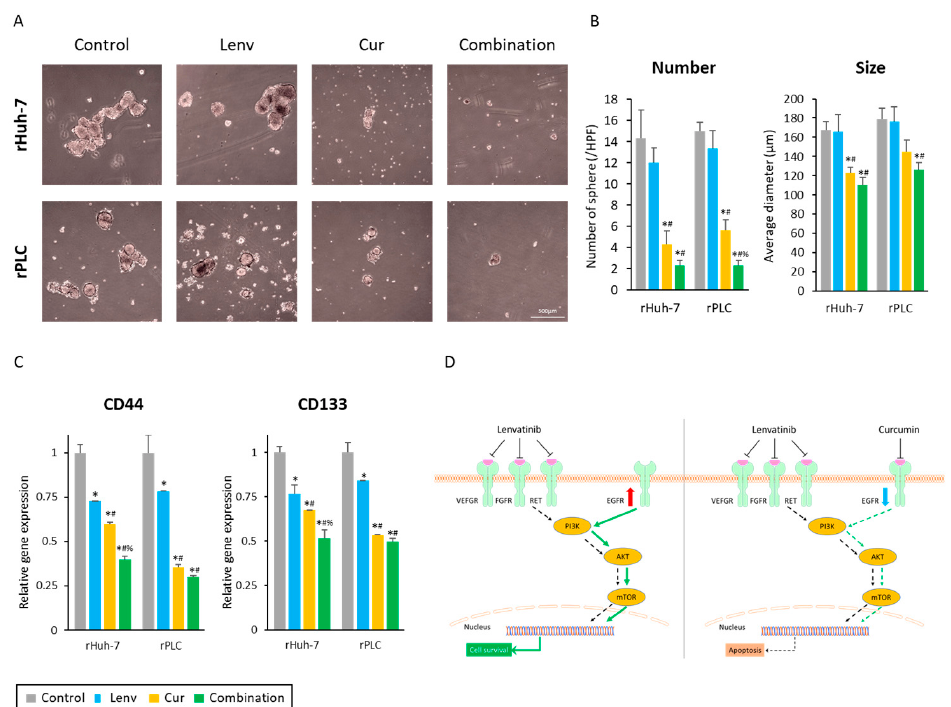
Figure 7. Co-administration of Lenvatinib with Curcumin diminished the spheroid-forming ability via suppression of cancer stemness markers. ( A ) Representative images of cancer spheroids from Lenvatinib-resistant cells following treatment (magnification 100 × ). Scale bar = 500 µ M. ( B ) Number and size of spheroids following treatment (*: p < 0.05 vs. control, #: p < 0.05 vs. Lenvatinib, %: p < 0.05 vs. Curcumin). ( C ) Gene expression changes in CD44 and CD133 genes (*: p < 0.05 vs. control, #: p < 0.05 vs. Lenvatinib, %: p < 0.05 vs. Curcumin). ( D ) A schematic illustration of the Curcumin and Lenvatinib combination treatment overcoming Lenvatinib resistance via suppression of EGFR and its downstream signaling. The data indicate mean (column) ± SD values. SD, standard